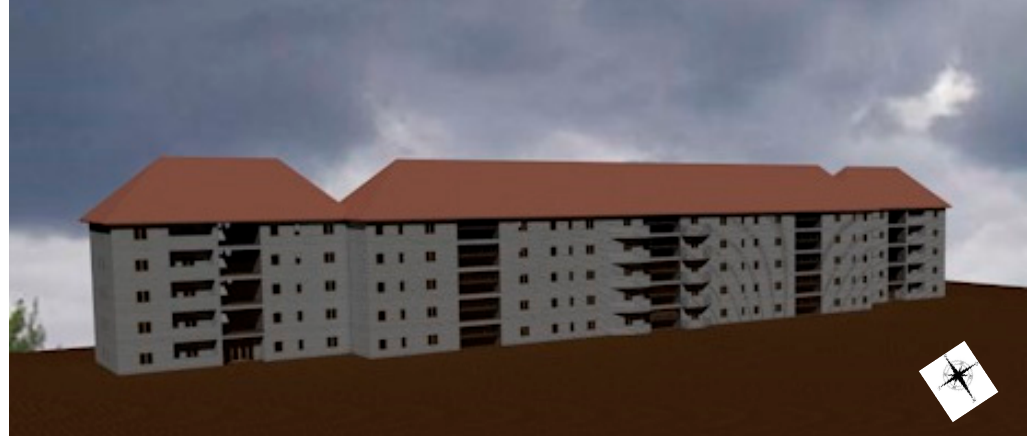
Figure 1. Perspective view of the investigated multistory residential building.